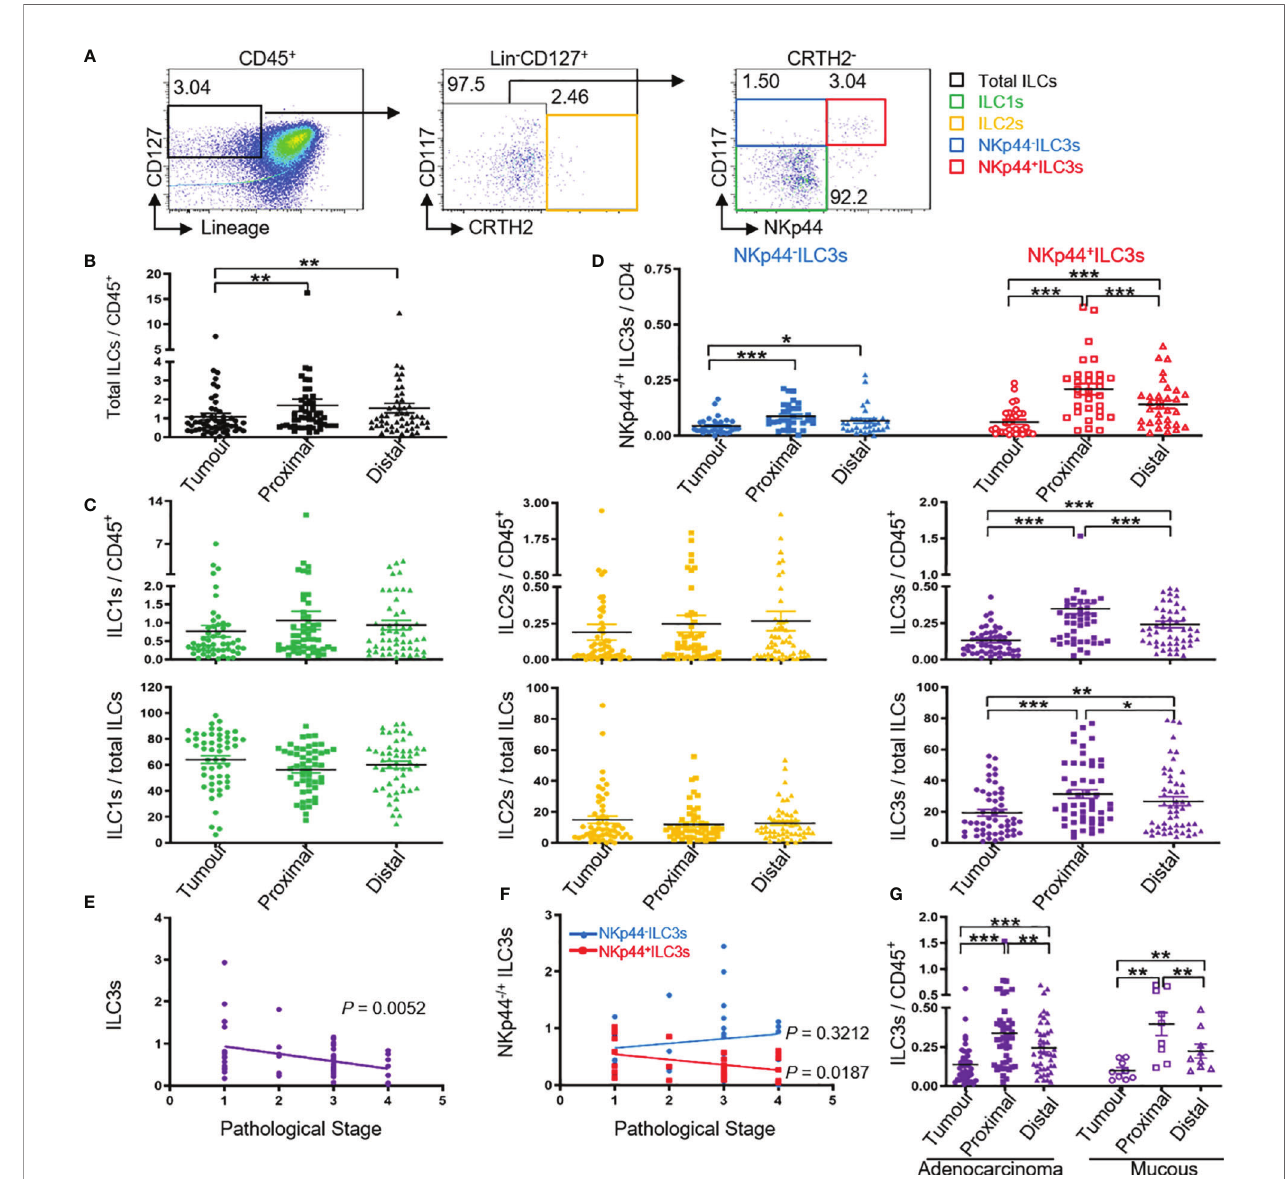
FIGURE 1 | Tumor ILC3s, especiallyNKp44 + ILC3s arenegativelycorrelatedwith pathological stage. Distribution ofILCs andILC subtypesbyFACS. MNCsfrom tumor, proximal, and distal regions of58 patientswithcoloncancer wereprepared. (A) The gatingusedtode fi neILCsubtypes: MNCs were stainedfor Lincocktail(CD3, CD14, CD19, andCD20), CD94, CD34, CD1a, TCR a / b , TCR g / d , CD45, CD127,CRTH2,andCD117. TotalILCs were identi fi edasLin − CD94 − CD34 − CD1a − TCR a / b − TCR g / d − CD45 + CD127 + , ILC1s wereidenti fi edas Lin − CD94 − CD34 − CD1a − TCR a / b − TCR g / d − CD45 + CD127 + CRTH2 − CD117 − , ILC2s were identi fi ed as Lin − CD94 − CD34 − CD1a − TCR a / b − TCR g / d − CD45 + CD127 + CRTH2 + , andILC3s were identi fi edasLin − CD94 − CD34 − CD1a − TCR a / b − TCR g / d − CD45 + CD127 + CRTH2 − CD117 + . ILC3swerefurther divided into NKp44 +/ − ILC3s. (B) ILC levels amongtheCD45 + cells intheindicatedtissues. (C) Percentage ofILC1s, ILC2s, and ILC3s among CD45 + cellsandtotal ILCs intheindicated tissues. (D) Percentageof NKp44 +/ − ILC3samong CD45 + cellsinthe indicated tissues. (E , F) Correlationbetweenthe percentage ofILC3s or NKp44 +/ − ILC3s intumor (T) versusdistal (D) tissueandthe pathological stage ofcancer. Thedistaltissue wasconsiderednormal tissue andwas usedfor normalizationto the background, hereT/D. (G) Percentage ofILC3s amongCD45 + cells incolonglandular cancer andmucous carcinoma tissue. In (B – D , G) , eachsymbolrepresents the indicated tissue from one patient (circle, tumor; square, proximalregion; triangle, distal region). In (A , E , F) , eachdot represents one patient.A paired t -testandSpearmantestwere usedfor statistical comparison. * P <0.05;** P <0.01; *** P <